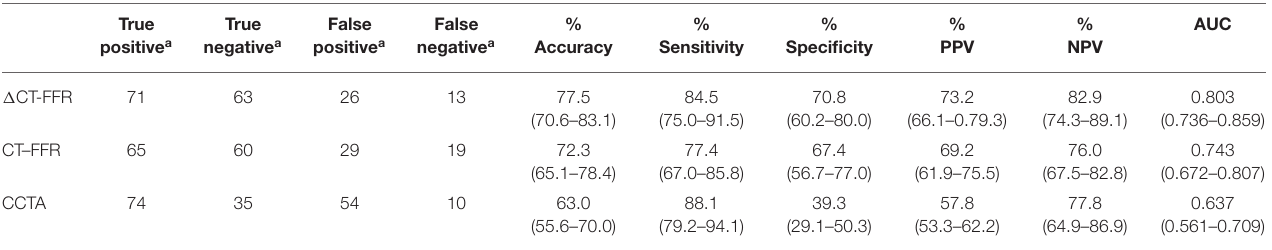
Except otherwise indicated, data are percentage with 95% confidence intervals. a Data are raw data. CT-FFR, computed tomography-derived fractional flow reserve; CCTA, coronary computed tomography angiography; PPV, positive predictive value; NPV, negative predictive value; AUC, area under curve; CI, confidence